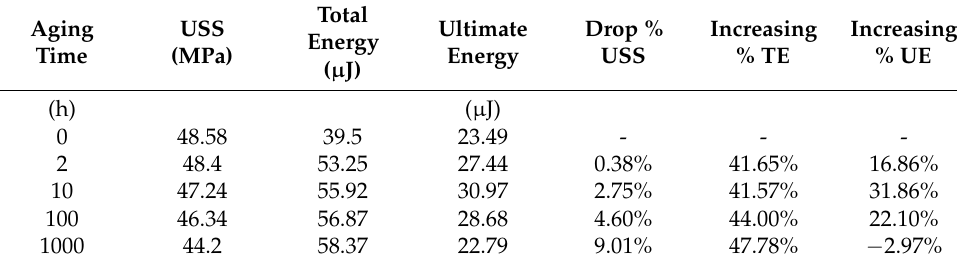
Table 4. Extracted mechanical properties of aged and nonaged SAC 305.